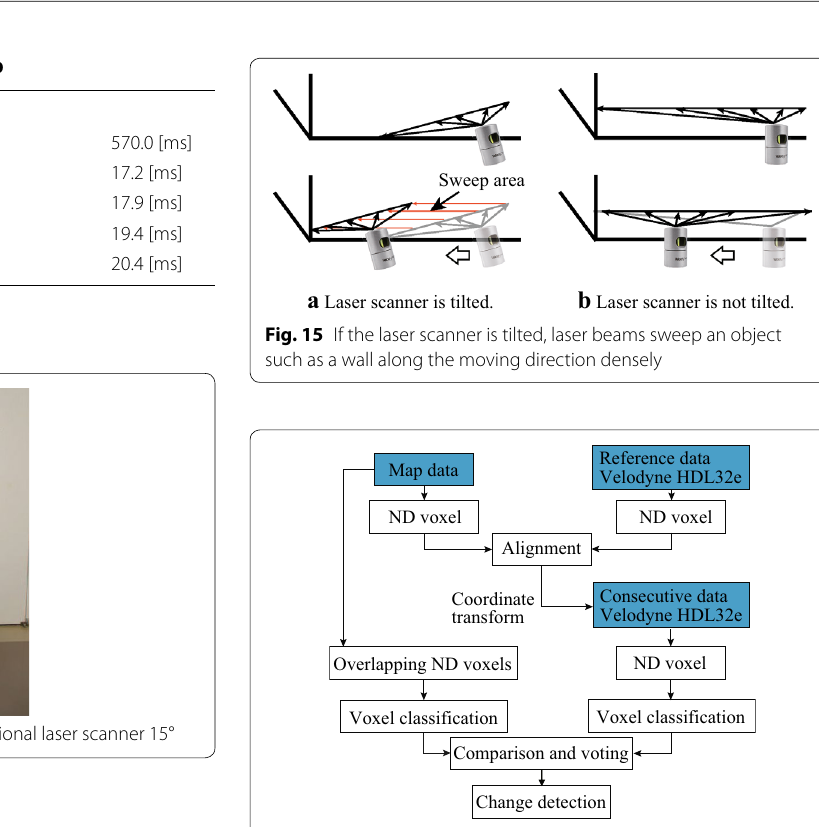
Fig. 16 The procedure of the outdoor